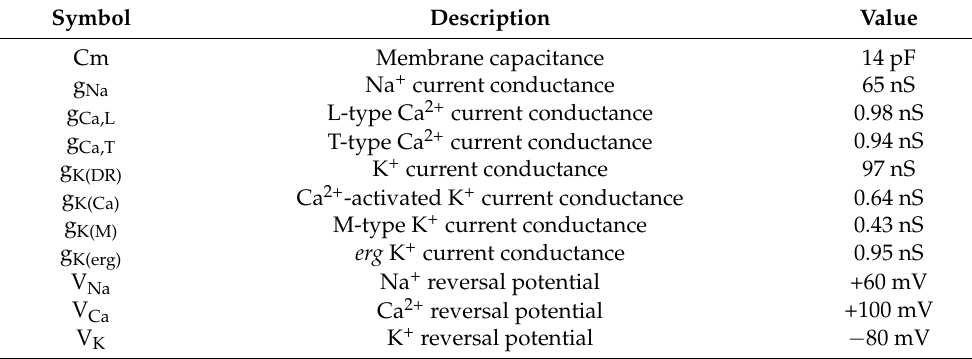
Table 2. Default parameter values used for the modeling of adrenal chromaffin